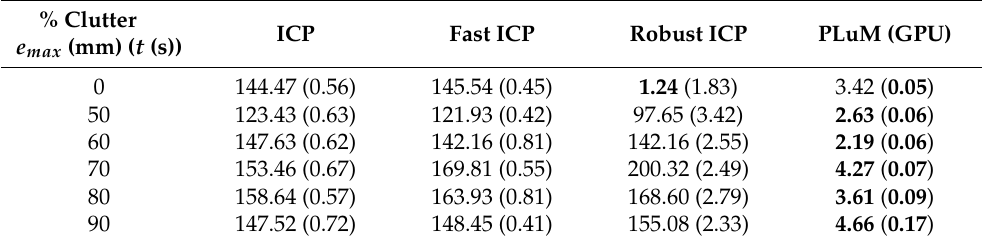
Figure 11. ( a ) Displays the performance of the registration algorithms with increasing random clutter. PLuM provides reliable results with varying amounts of clutter in the point cloud, as measurements that do not fit the model do not penalise the correct hypothesis. ( b ) Shows the slightly increasing execution time of the PLuM algorithm as the point cloud size increases due to the added clutter. The timeliness of the other methods can be disregarded, as they fail to provide an accurate registration result. Table 4. The maximum vertex error and execution time for each method. The best results are displayed in